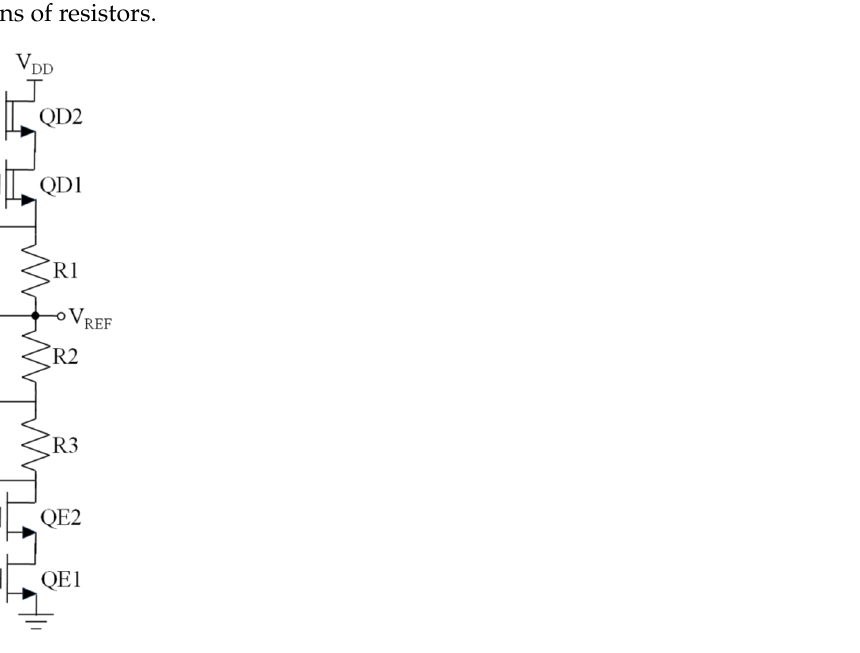
Figure 5. Proposed single-branch, double wide-swing-cascode, voltage